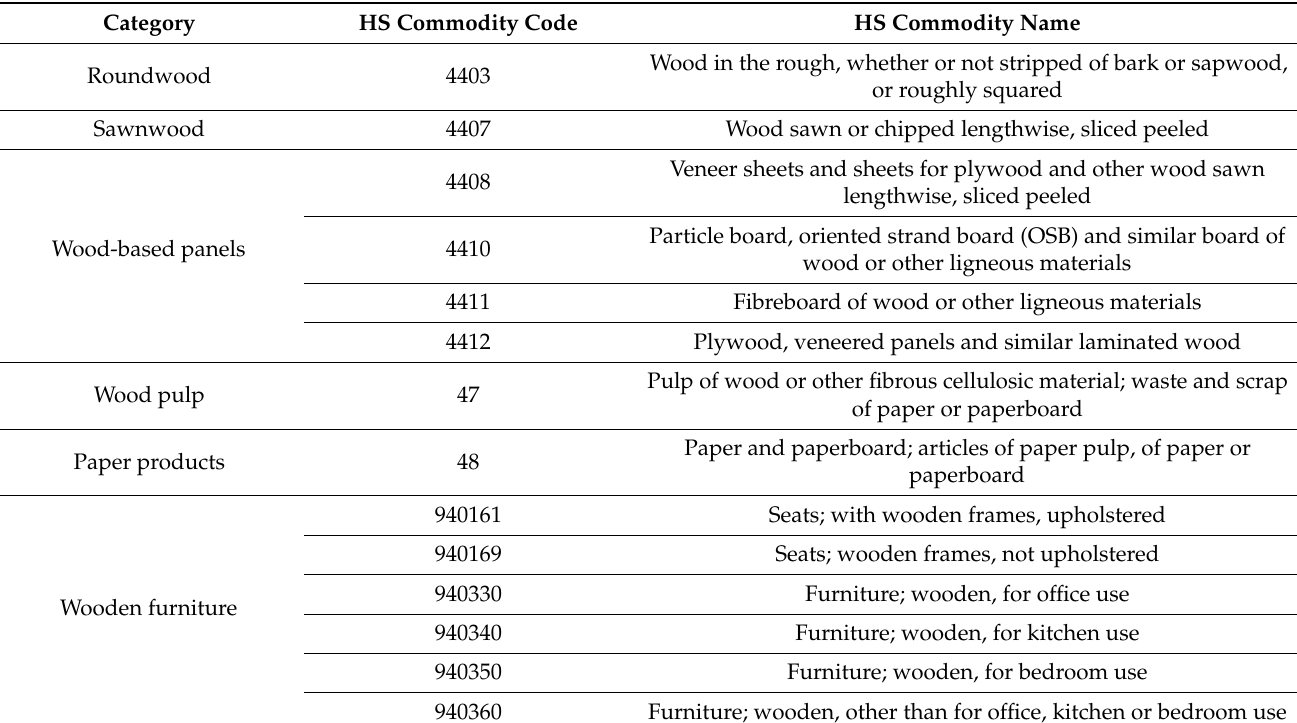
Table 2. Classification of wood forest products in this